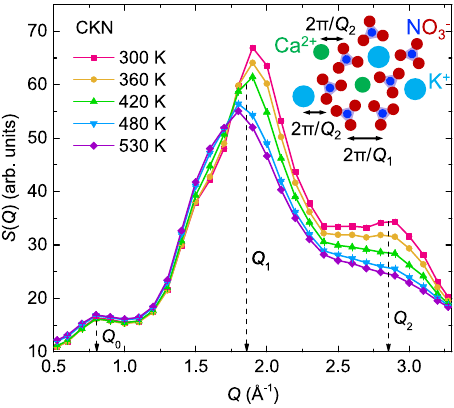
Fig. 1 Static structure factor of CKN obtained from neutron scattering. The measurements were performed at fi ve different temperatures from the glass (300 K) up to the low-viscosity liquid (530 K) states. The inset is an illustration of CKN structure with indicated correlation lengths; the triangles represent nitrate ions NO 3 − with oxygen atoms as red circles and nitrogen atoms as blue circles, the sky-blue and green circles are potassium ions K + and calcium ions Ca 2 + , respectively; the arrow lines represent the length scales corresponding to the primary peak around Q 1 ≈ 1.86 Å − 1 originating mainly from the correlation of neighboring nitrate ions, and the broad peak at Q 2 ≈ 2.85 Å − 1 manifesting mainly the ionic oxygen-cation correlations. The illustration for the length scale corresponding to the pre-peak at Q = 0.8 Å − 1 arising from the intermediate-range aggregates of nitrate ions 0 is not shown. Error bars represent one standard error and are smaller than the symbol size. Source data are provided as a Source Data fi